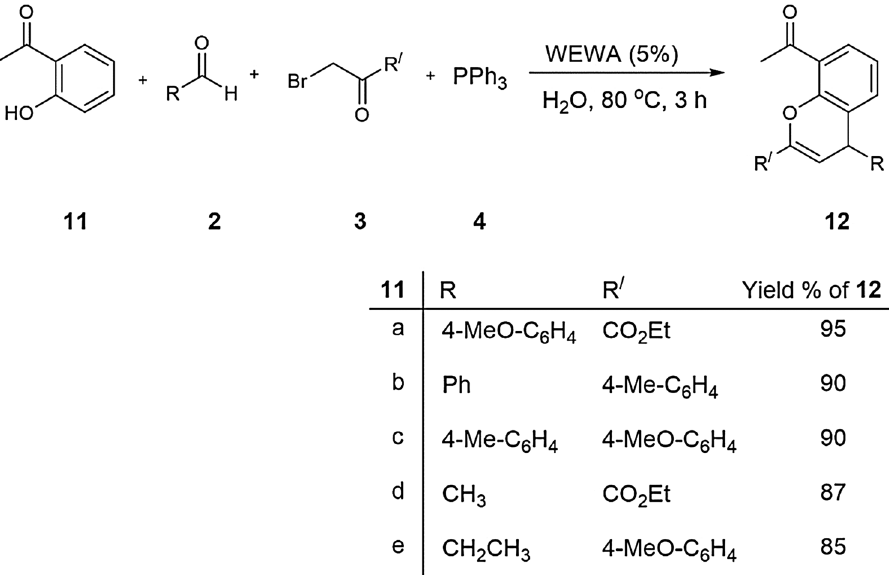
Figure 7. Three-component reaction for synthesis of benzochromene derivatives of 12 in